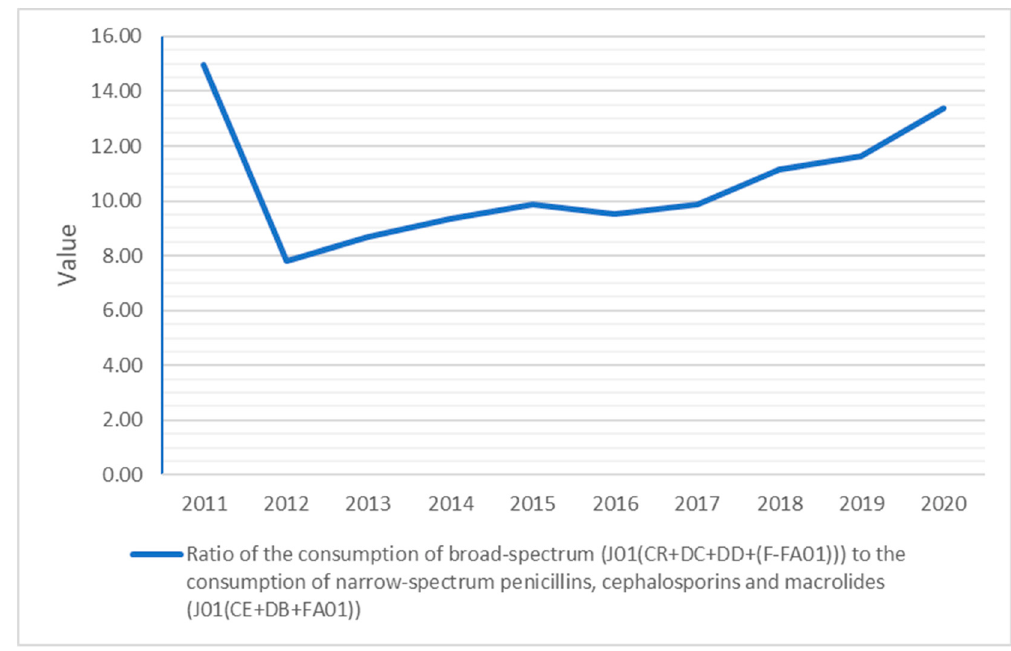
Figure 7. Quality indicators related to the consumption of broad-spectrum and narrow-spectrum antibiotics in the community from 2011 to 2020.